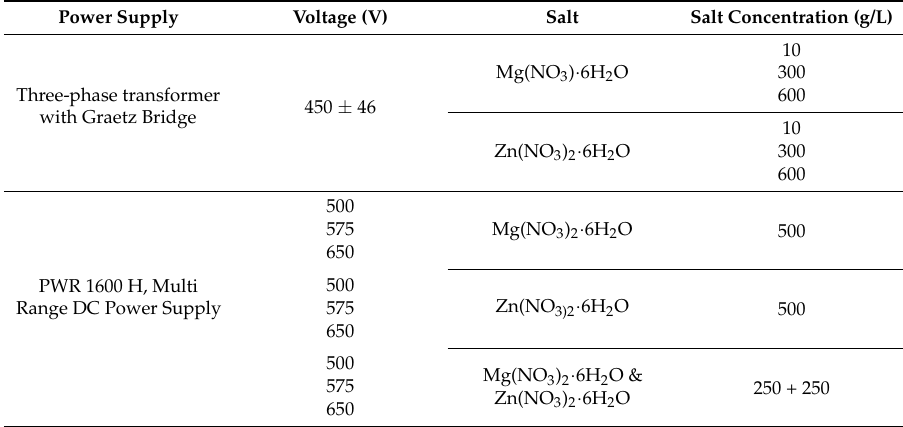
Table 2. Electrolytes used to oxidize the titanium by (PEO) treatment.